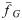
Scatter plots, by treatment, of native tolerance (f¯G) and migrant tolerance (f¯B) against the rate of change of tolerance (Δf), in steady-state at t = tmax.